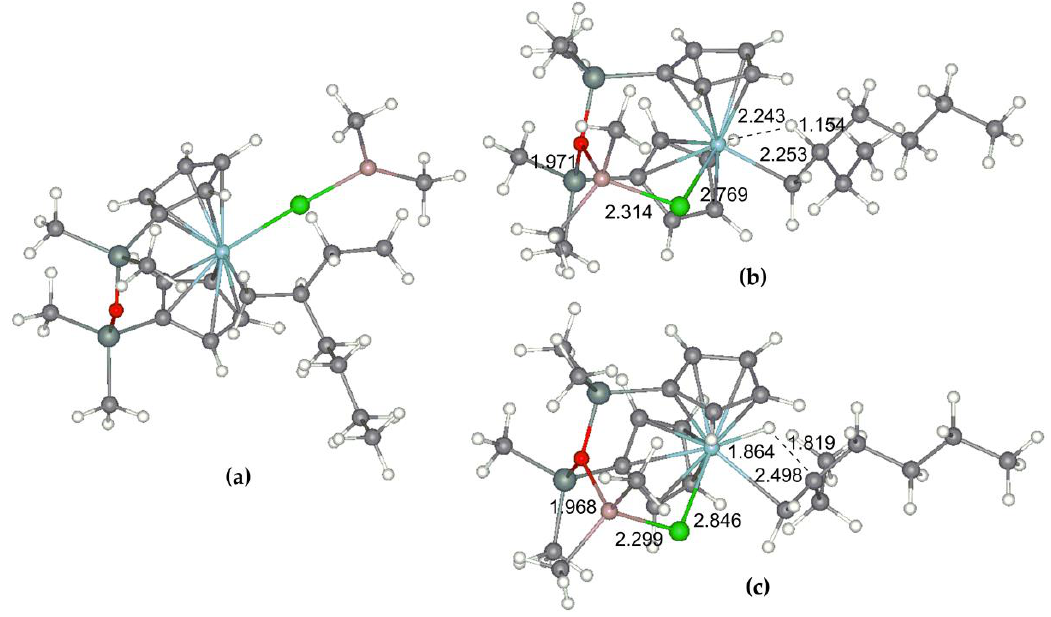
Figure 4. Optimized geometries of O[SiMe 2 ( η 5 -C 5 H 4 )] 2 Zr–derived stationary points I-5pp-Cl ( a ), I-5pp-c-Cl ( b ) and transition state TS-56pp-c-Cl ( c ) .